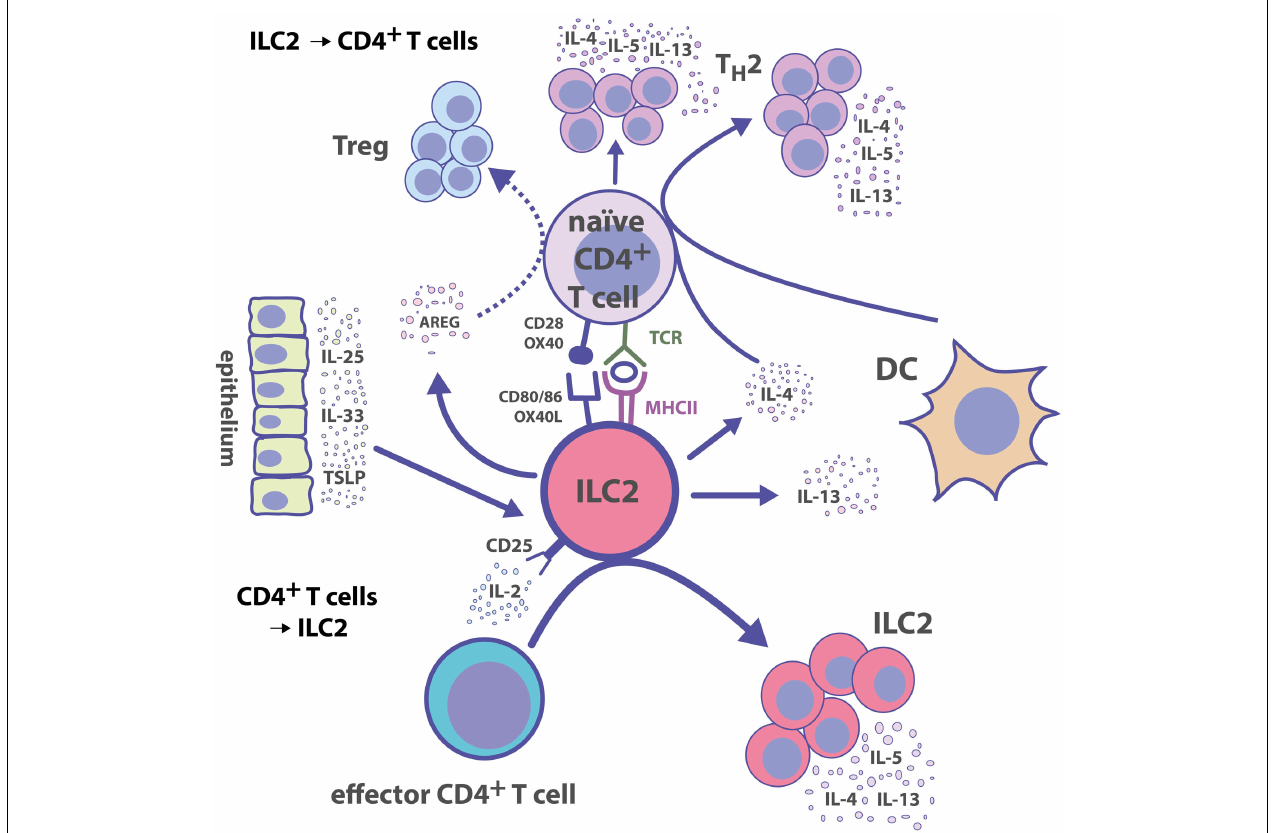
FIGURE 1 | Group 2 ILC–CD4 +++ T cell interactions . ILC2s polarize CD4 + T cell responses toward T H 2 immunity directly by presenting cognate Ag and by secreting T H 2-inducing cytokines. Reciprocally, activated CD4 + T cells produce IL-2, which serves as a growth factor leading to the expansion of